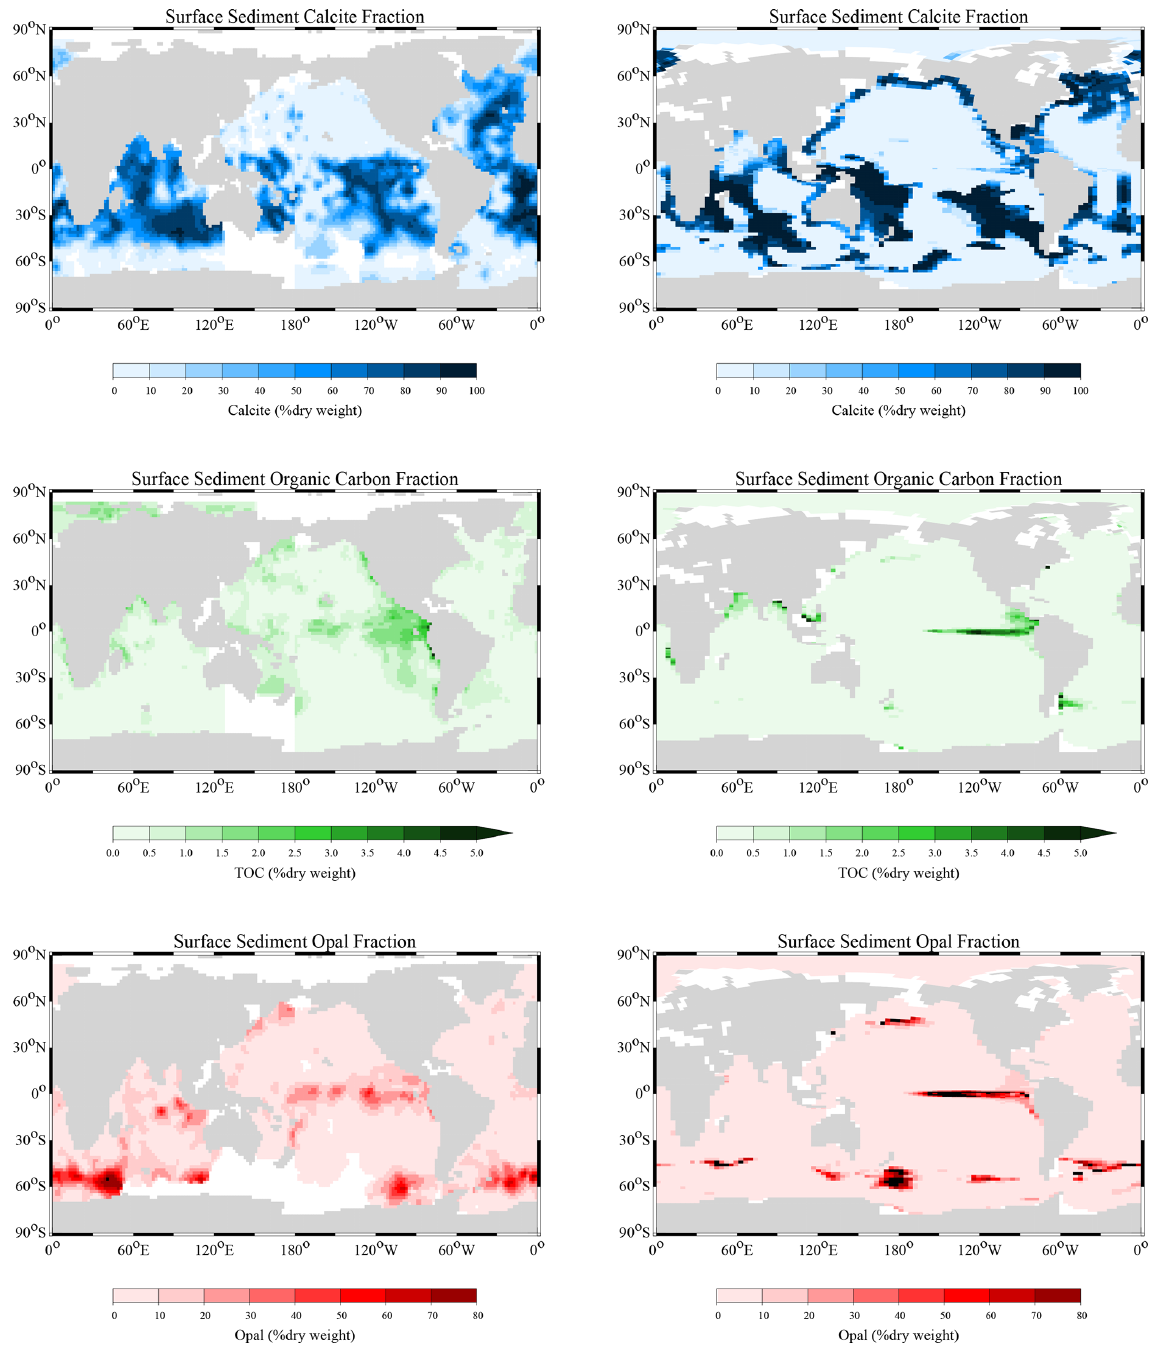
Figure 4. Left column: data (Seiter et al., 2004) binned to a 2 ◦ × 2 ◦ resolution comparable to the average resolution of BEC; right column: COUPSIM (i.e. MEDUSA forced by the BEC model results of Moore et al., 2004).